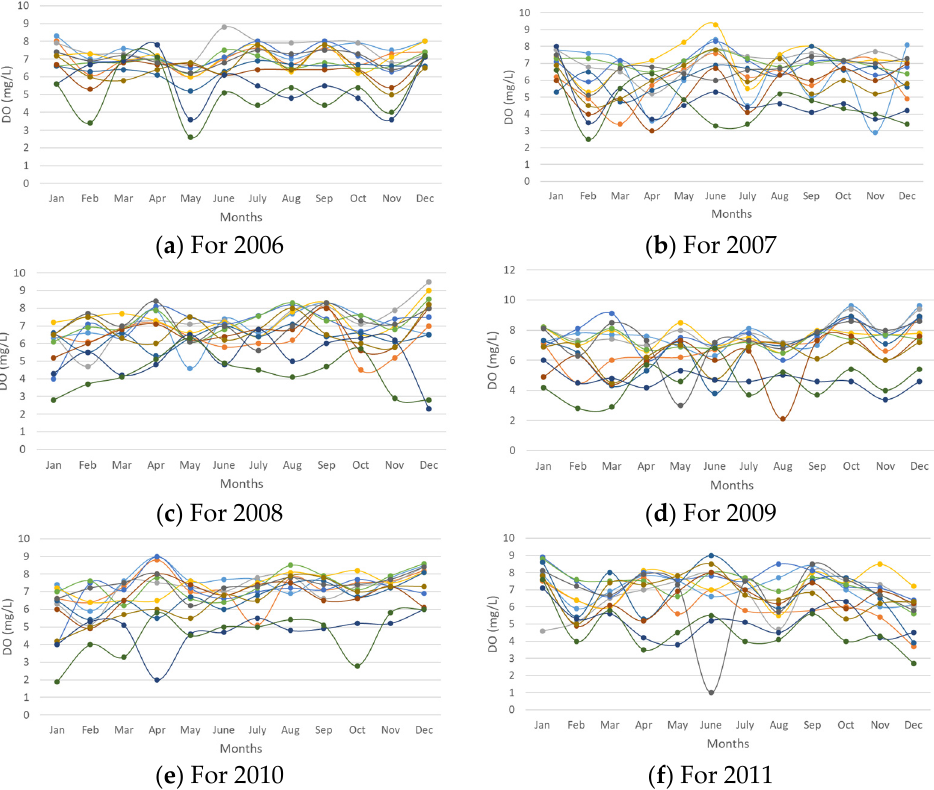
Figure A1. DO variation along the Kelani River basin: ( a ) For 2006; ( b ) For 2007; ( c ) For 2008, ( d ) For 2009; ( e ) For 2010; ( f ) For 2011.